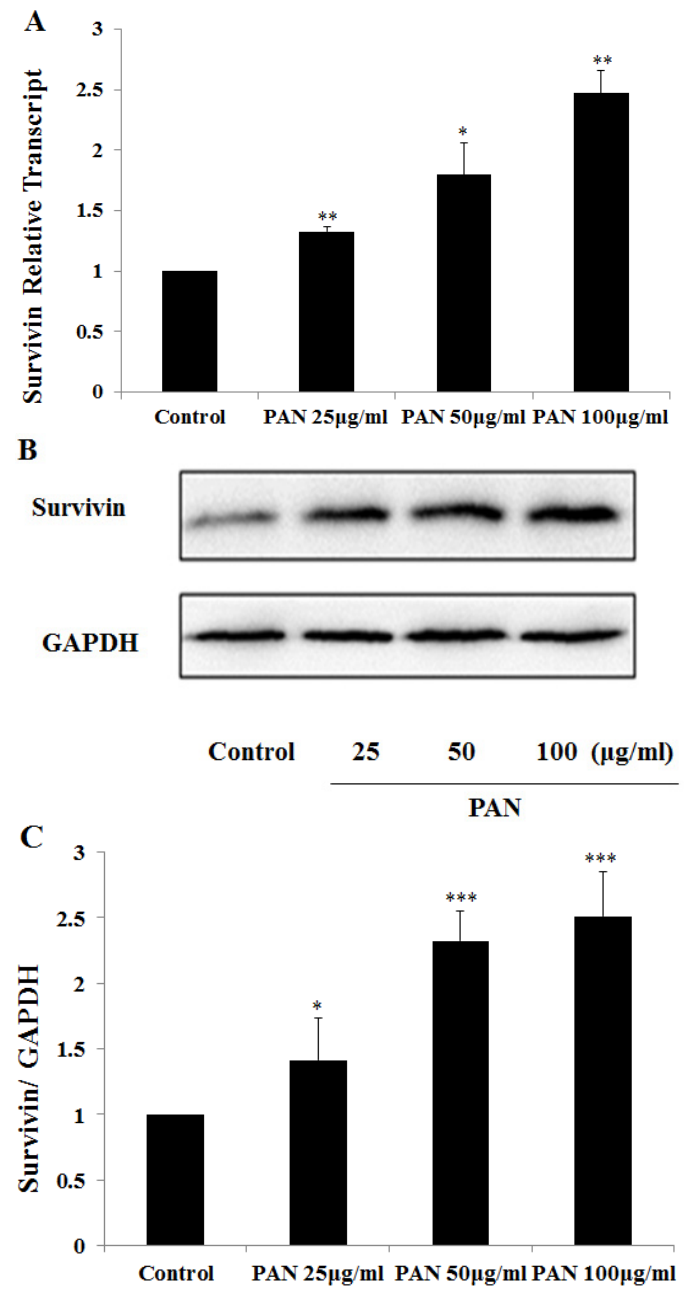
Figure 1. Survivin expression increased in podocytes after puromycin aminonucleoside (PAN) treatment for 24 h. ( A ) The RNA level of survivin was evaluated by the Quantitative Real-Time PCR; ( B ) The protein level of survivin was performed by western blot; ( C ) The amounts of protein were quantified and calibrated with the expression of GAPDH. Data are presented as mean ± SD. n = 3. * p < 0.05, ** p < 0.01, *** p <